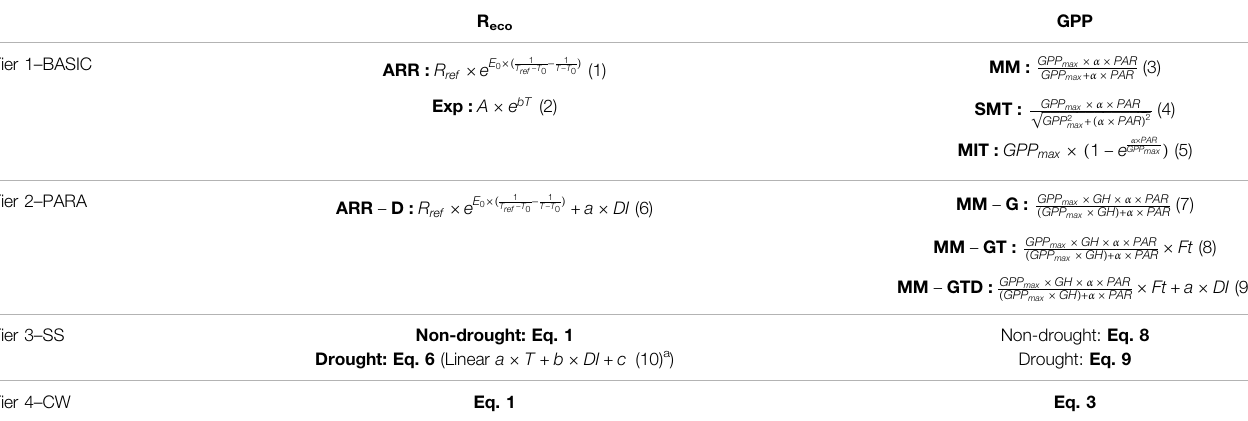
TABLE 1 | Equations of the empirical models selected for the gap- fi lling framework.